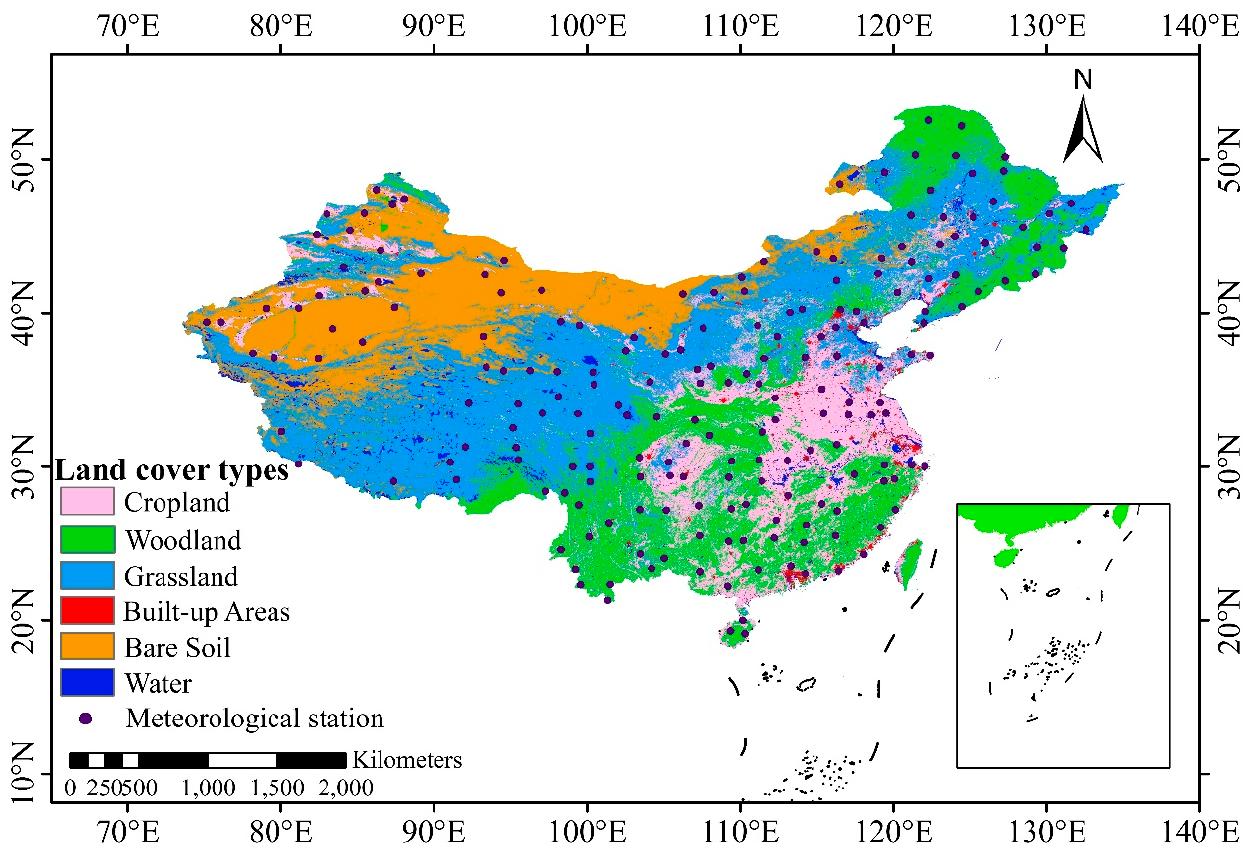
Figure 1. Land-cover map across China. The dots indicate the location of meteorological stations collected from China Meteorological Administration.